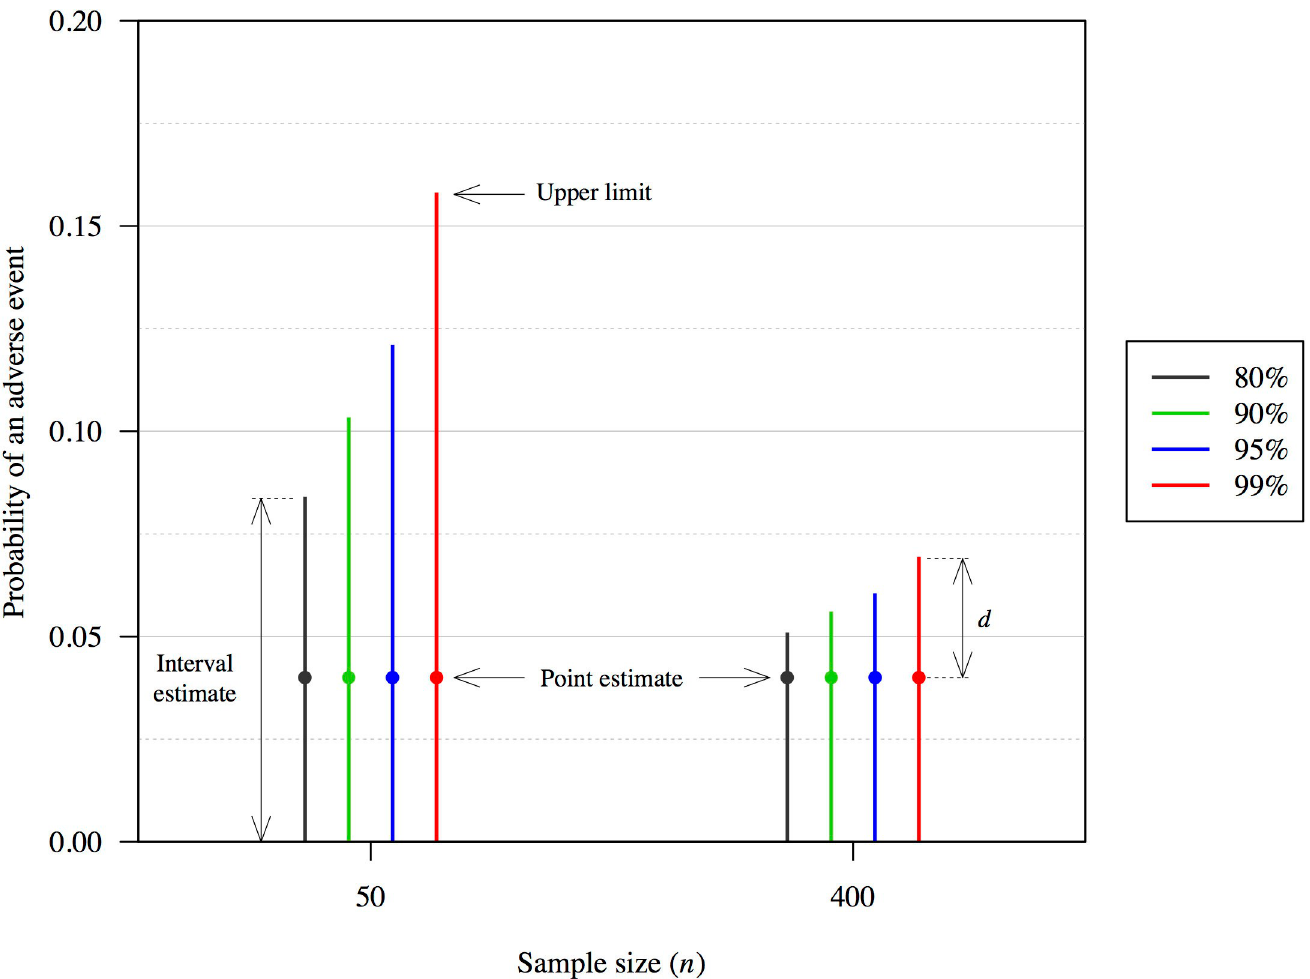
Fig 1. Examples of one-sided confidence interval estimates of frequency, with a point estimate of 0.04. Confidence levels of 80% (black), 90% (green), 95% (red) and 99% (blue), and sample sizes ( n ) of 50 and 400 are presented to illustrate the effect on the resulting interval estimate. The distance from the point estimate to the upper limit is indicated ( d